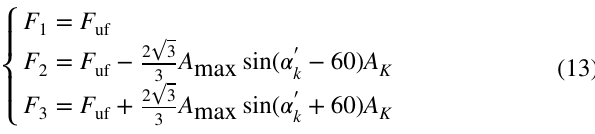
Fig. 13 Steering and pad forces when 150 < α